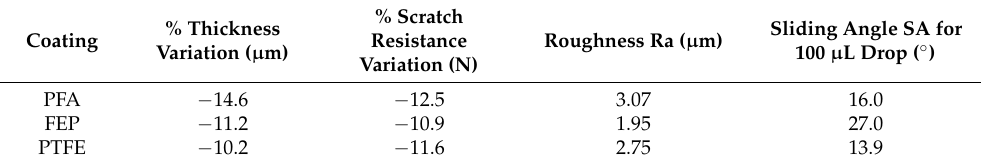
Table 4. Properties of fluoropolymeric coatings after 4 s of wear by glass microspheres at 0.4 MPa. Coating % Thickness Coating Variation ( µ m)